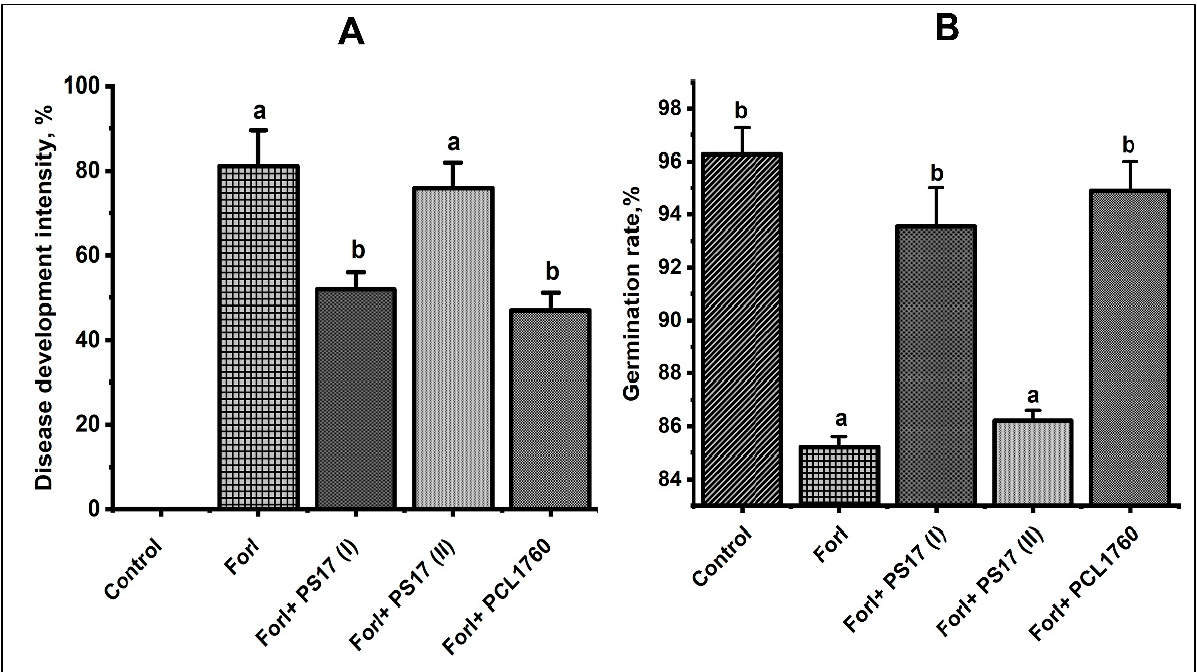
Figure 11. Biocontrol properties ( A ) and germination rates ( B ) of B. mojavensis PS17 morphotypes I and II on tomato plants against ForI ZUM2407, PS17(I), PS(II), and PCL1670. The experiment was performed in duplicate and repeated twice. Statistical differences between groups are indicated by different letters (a and b) to the least significant difference at a p -value < 0.05.